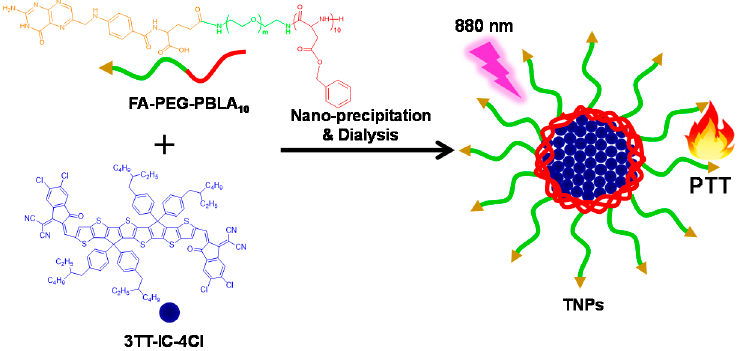
Figure 1. Schematic illustration demonstrating of stable nanoparticles (TNPs) formation and pho- tothermal therapy (PTT) effect.